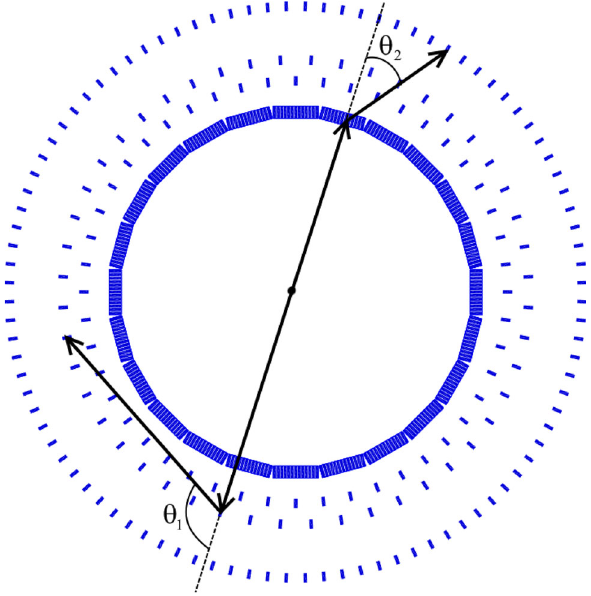
Fig. 2 Cross section of the updated J-PET detector. Superimposed arrows indicate primary and scattered momenta of photons originating from para-positronium decaying in the center of the detector. Detector is build from plastic scintillators strips arranged axially in four